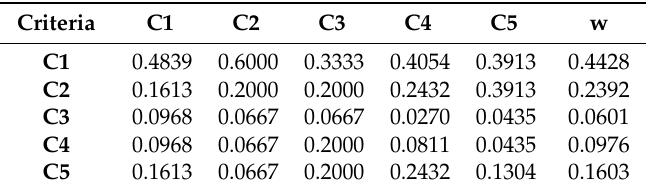
Table 2. Normalized matrix B